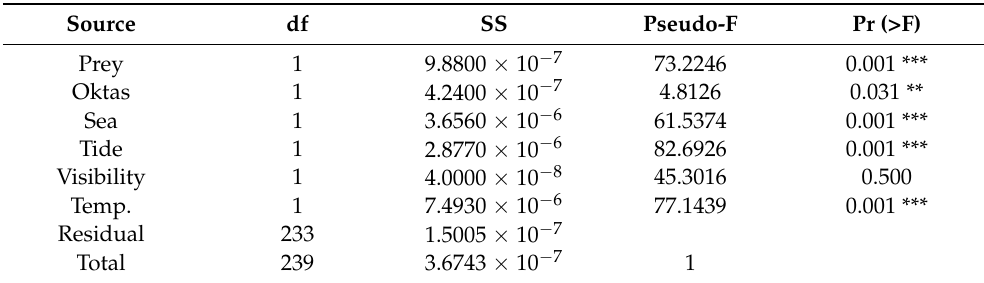
Table 1. PERMANOVA analysis between the elements ‘years’ and ‘effects’ across units. Here, the labels stand for ‘degrees of freedom’ (df), ‘sum of squared dissimilarities’ (SS), ‘Pseudo F statistic’ (Pseudo-F), and ‘associated p -value’ (Pr (>F)). The significance levels are: (**) significance at 5%; and (***) significance at 1%. df SS